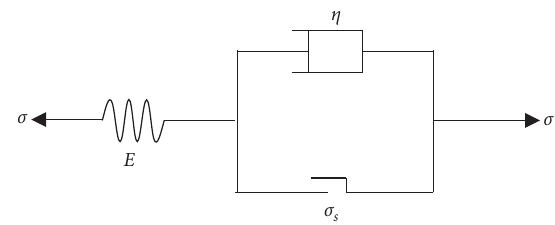
Figure 19: Schematic diagram of the Bingham